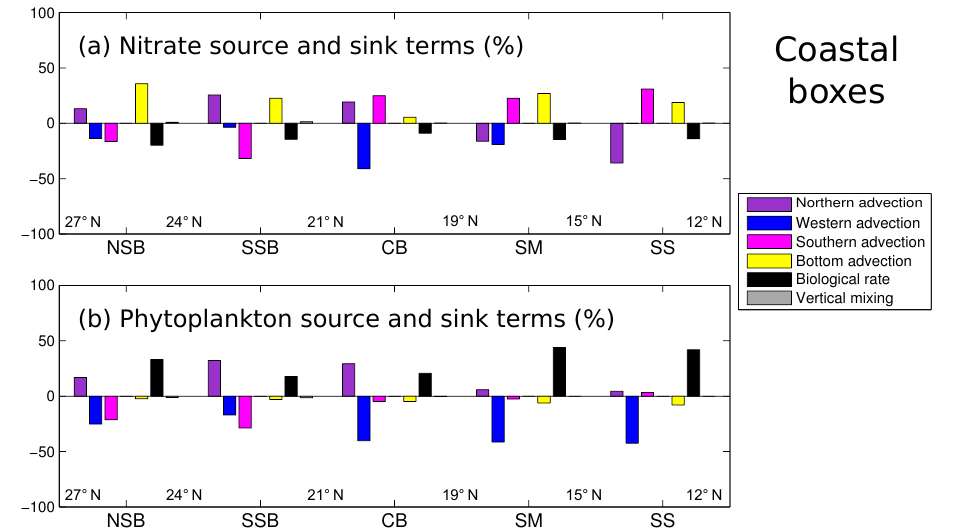
Figure 6. Annual mean contribution of the different source and sink terms of (a) nitrate and (b) phytoplankton biomass in the coastal boxes (%, positive inward): northern, western and southern horizontal advection, vertical advection and diffusion (vertical mixing) at the bottom and net local biological rate of change. From north to south: northern Saharan Bank (NSB), southern Saharan Bank (SSB), Cape Blanc area (CB), Senegalo-Mauritanian region (SM) and southern Senegal region